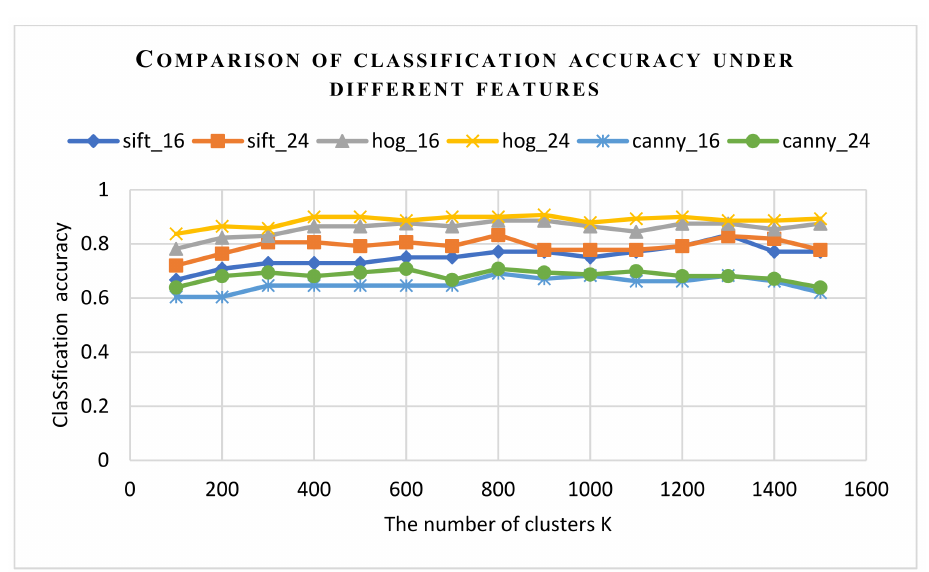
Figure 8. Comparison of classification accuracy under different